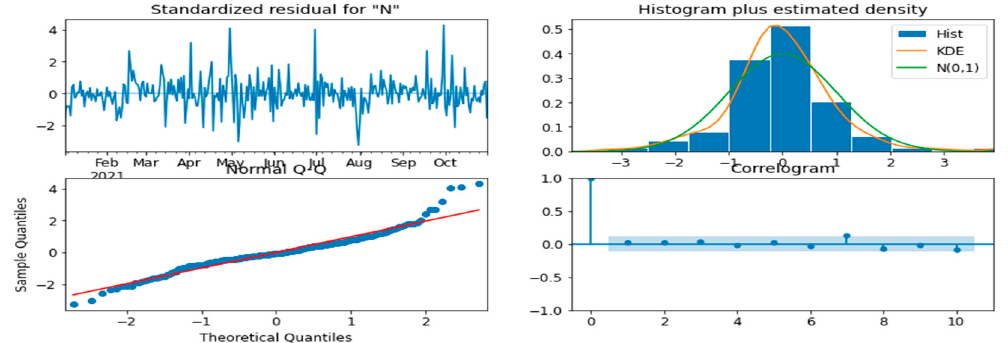
Table 3. Prediction performance of the different models SARIMA vs. Prophet models.